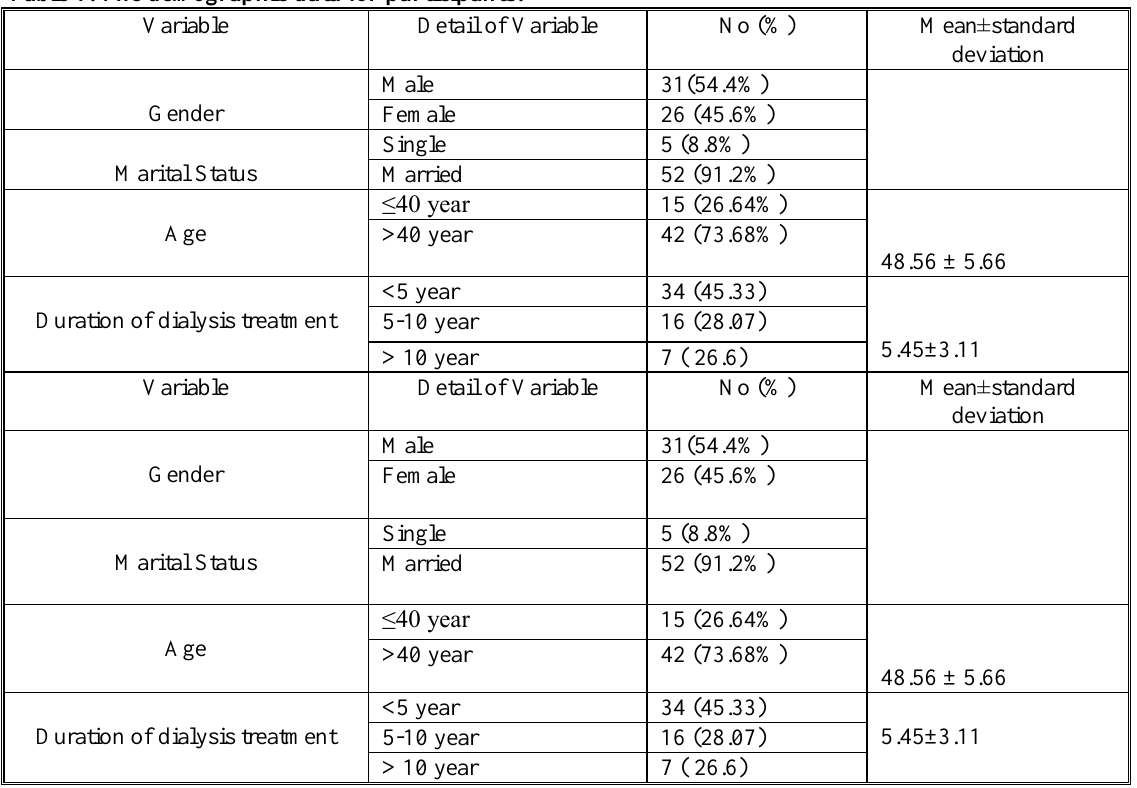
Table 1. The demographic data for